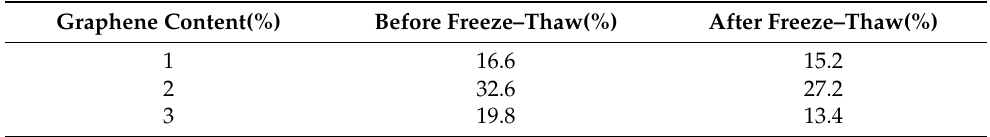
Table 10. Temperature sensitivity of electrical resistivity of specimens incorporating different graphene contents subjected to multiple temperature rise and fall before and after freeze–thaw.